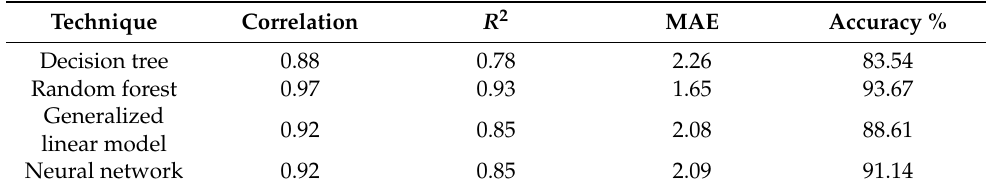
Table 8. Comparison of the performance of machine learning techniques in terms of the prediction of